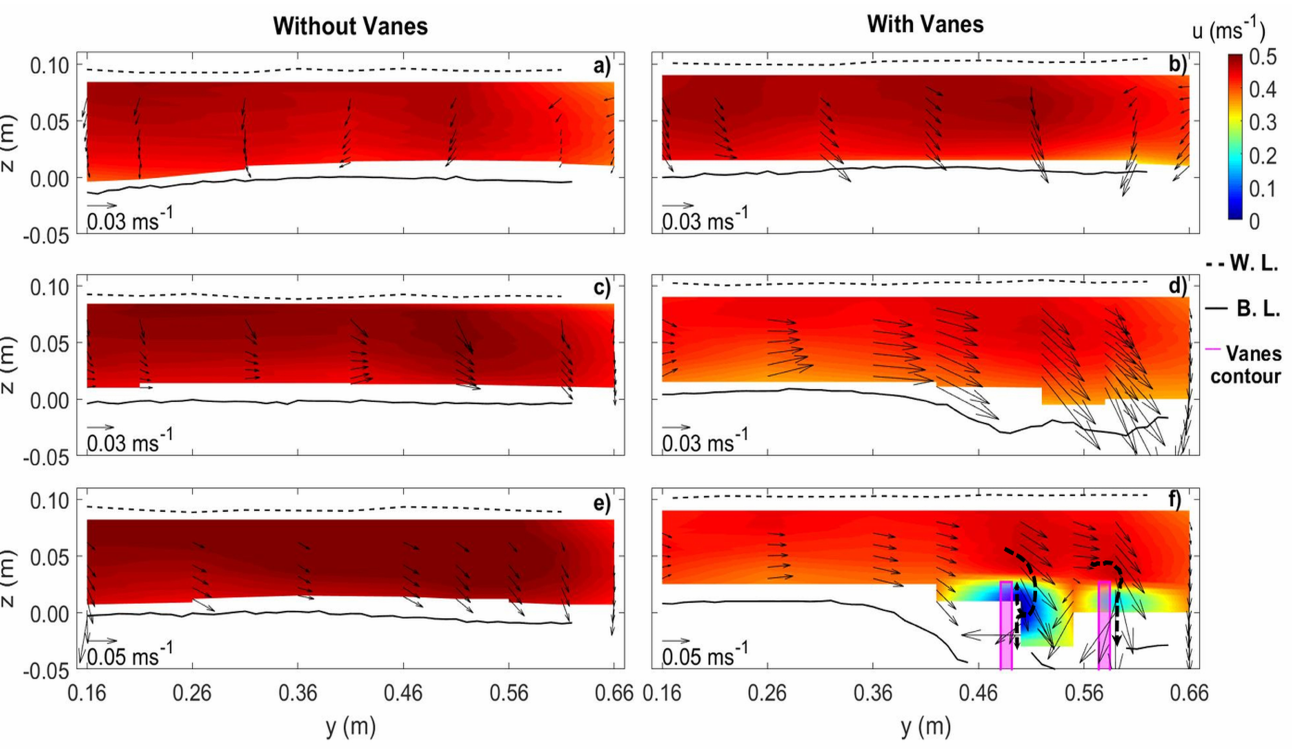
Figure 8. Velocity u (ms − 1 ) as color scale and direction and magnitude of the velocity components ( v , w ) (ms − 1 ) as vector arrows, in the NV and the VF experiments, at cross-sections of the approach-flow zone: ( a ) x = − 1.00 m. ( b ) x = − 1.00 m. ( c ) x = − 0.40 m. ( d ) x = − 0.42 m. ( e ) x = − 0.30 m. ( f ) x = − 0.36